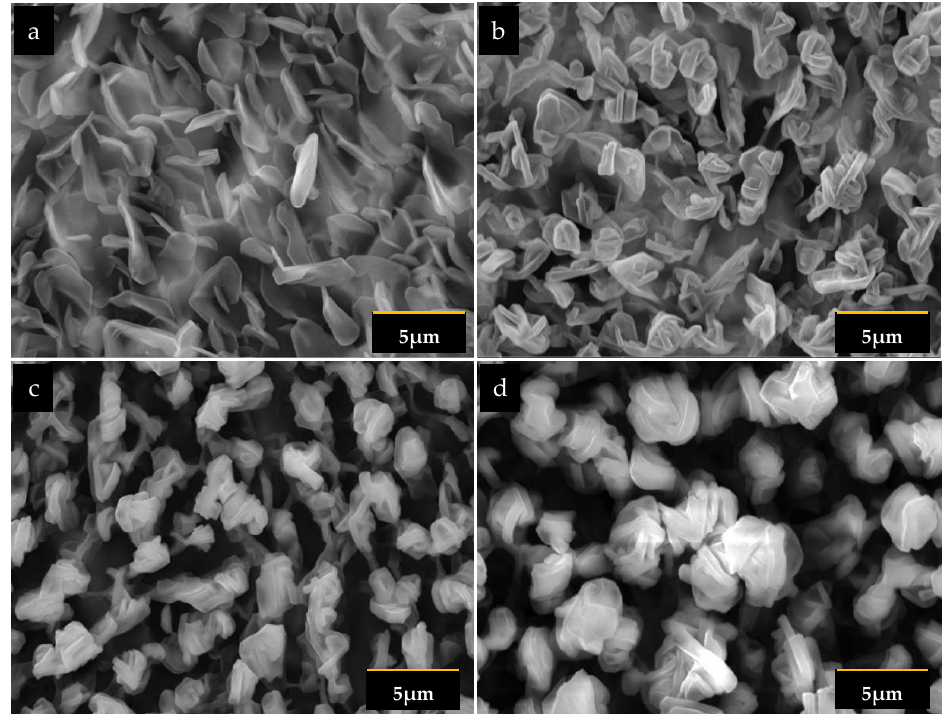
Figure 2. Top view electron micro-image of the stearic acid layer deposited at: ( a ) 1 min; ( b ) 2 min; ( c ) 3 min, and ( d ) 4 min.